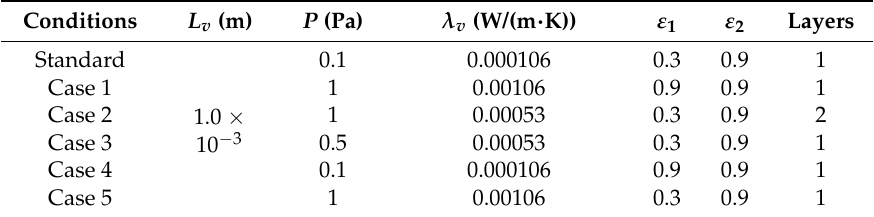
Table 2. Calculation conditions in the case studies.